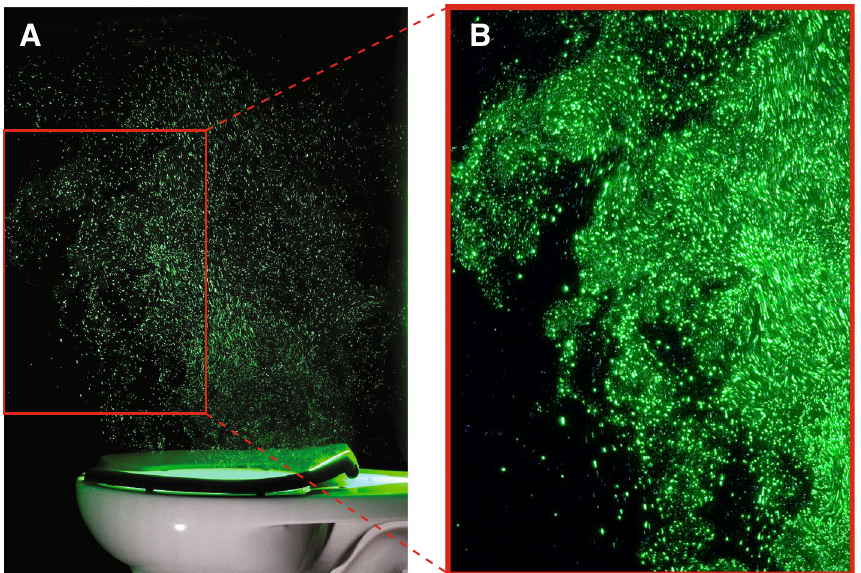
Figure 6. Imaged particles are good indicators of the plume envelope. ( A ) The third panel of the plume ( t = 6.4 s) from Fig. 2 is reproduced here for reference, showing the location and motion of larger particles. ( B ) Enlarged image of the region denoted by the red box in part A, post-processed to increase exposure and decrease contrast. This renders dimmer light from smaller particles visible, and demonstrates that the smaller particles (green glow) are well predicted by the locations of larger particles (imaged as discrete points of light). Also visible in the lower left are several large droplets that are following ballistic trajectories and are outside the aerosol plume